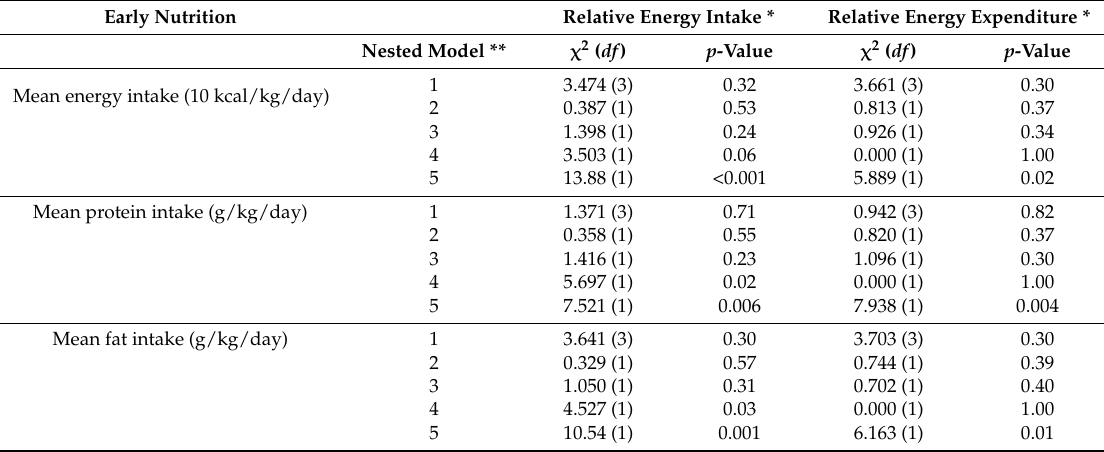
Table 4. Test results of five alternative nested models for full path model and relative energy intake and relative REE as outcome variables.